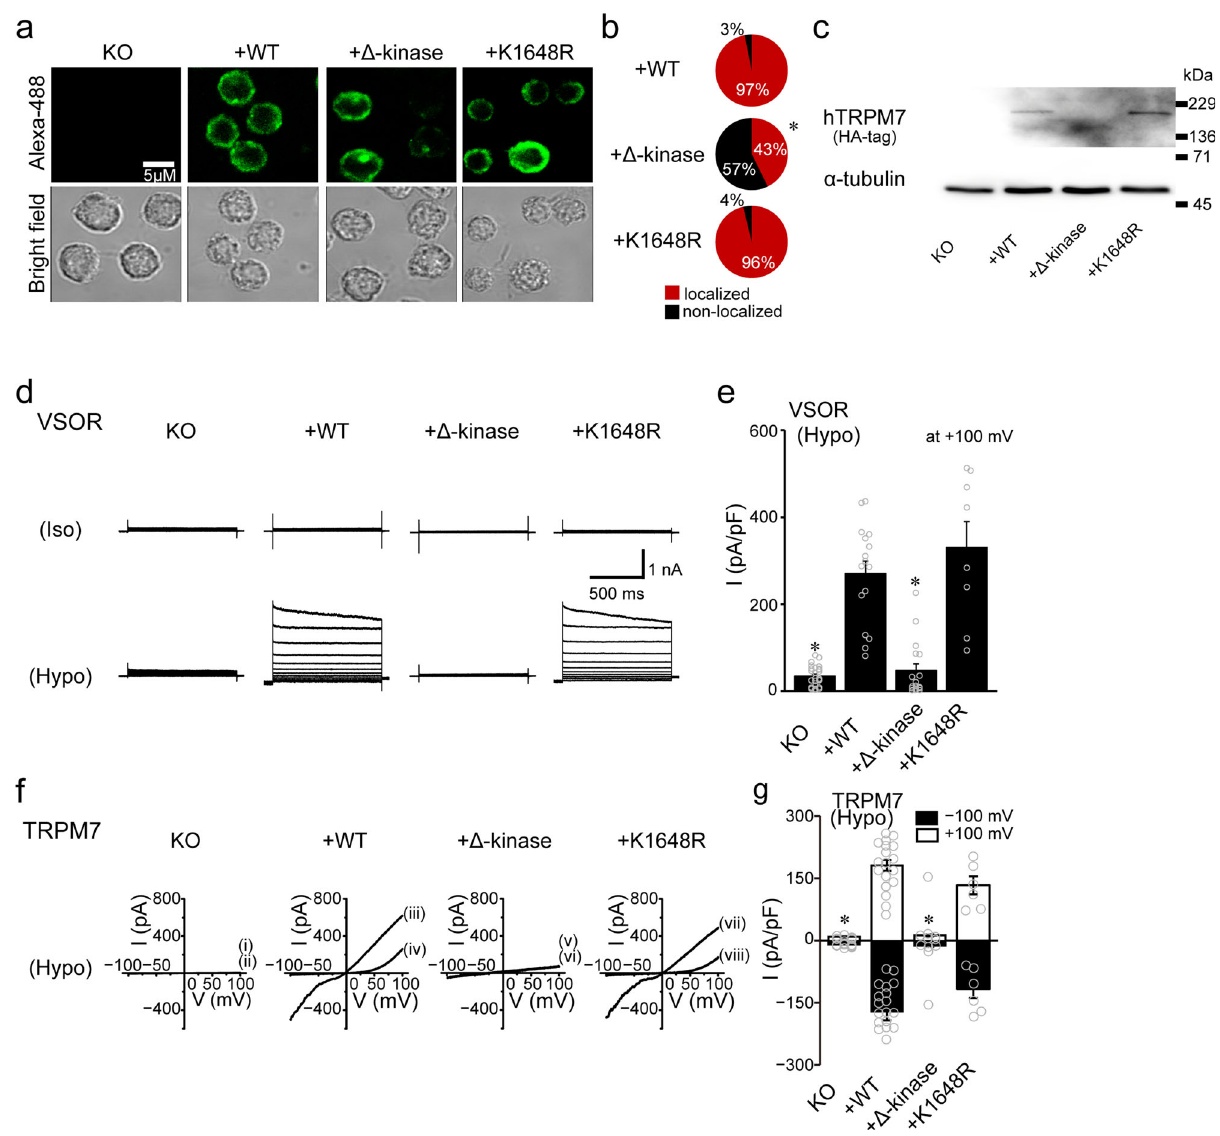
Fig. 8 Effects of gTRPM7 knockout and complementary expression with hTRPM7 or its mutant on the protein expression monitored by immunohistochemistry as well as on VSOR and TRPM7 currents recorded by whole-cell patch-clamp in DT40 cells. a Representative fl uorescence micrographs of gTRPM7-KO DT40 cells immunostained with anti-HA antibody before ( KO ) and after complementary expression with WT hTRPM7 or its mutant (Alexa-488: green) as well as their bright fi eld micrographs. Scale bar, 5 μ m. b The percentage of TRPM7 localization to the plasma membrane is signi fi cantly lower in the C -terminal defects ( + Δ -kinase: * P ( = 1.1 × 10 − 233 ) <0.0001 compared to + WT data by χ 2 test). Observations and analyses were performed from 53 – 110 individual cells. c Western blot analyses of α -tubulin, HA-tagged hTRPM7 from KO, + WT, + Δ -kinase , and + K1648R DT40 cells. The data are representative of three independent experiments. d Representative whole-cell VSOR currents elicited by step pulses in isotonic conditions ( Iso ) and in hypotonic conditions ( Hypo ) in gTRPM7-knockout ( KO ) DT40 cells and those complemented with hTRPM7 ( + WT ), hTRPM7- Δ -kinase ( + Δ -kinase ), and hTRPM7-K1648R ( + K1648R ). e Peak VSOR current densities recorded at + 100 mV ( n = 8 – 26). Each column represents the mean ± SEM (vertical bar) of n samples. * P ( = 0.000000000069 and 0.0000000029 for KO and + Δ -kinase , respectively) <0.0001 compared to corresponding + WT data by one-way ANOVA followed by the post hoc Tukey ’ s test. f Representative I – V relationships of whole-cell TRPM7 currents in KO , + WT , + Δ -kinase , and + K1648R DT40 cells exposed to hypotonic (86% osmolarity) solution. The I – V curves were recorded under ramp-clamp (50-ms duration applied every 5 s at 4 mV/ms) from − 100 to + 100 mV in the absence (i, iii, v, vii) and presence (ii, iv, vi, viii) of 1-mM Mg 2 + . g Peak current densities recorded at + 100 mV (blank columns) and – 100 mV ( fi lled columns) in hypotonic conditions ( n = 6 – 19). Each column represents the mean ± SEM (vertical bar) of n samples. * P ( = 0.0000029 and 0.0012 at – 100 mV and 0.00000000020 and 0.0000015 at + 100 mV for KO and + Δ -kinase , respectively) <0.005 compared to corresponding data in + WT cells by one-way ANOVA followed by the post hoc Tukey ’ s Next, we examined possible spatial co-localization of TRPM7 with WT TRPM7 or the K1648R mutant, whereas such periphery and LRRC8A in HeLa cells transfected with TRPM7-EGFP and localization of LRRC8A was not much observed in those LRRC8A-mCherry. Only after a hypotonic challenge, as shown transfected with the Δ -kinase mutant. Also, their merged images in Fig. 9 (a, b: LRRC8A-mCherry ), LRRC8A was found to suggest that LRRC8A becomes apparently co-localized with WT become localized to the periphery region of cells transfected TRPM7 or the K1648R mutant but not much with the Δ -kinase